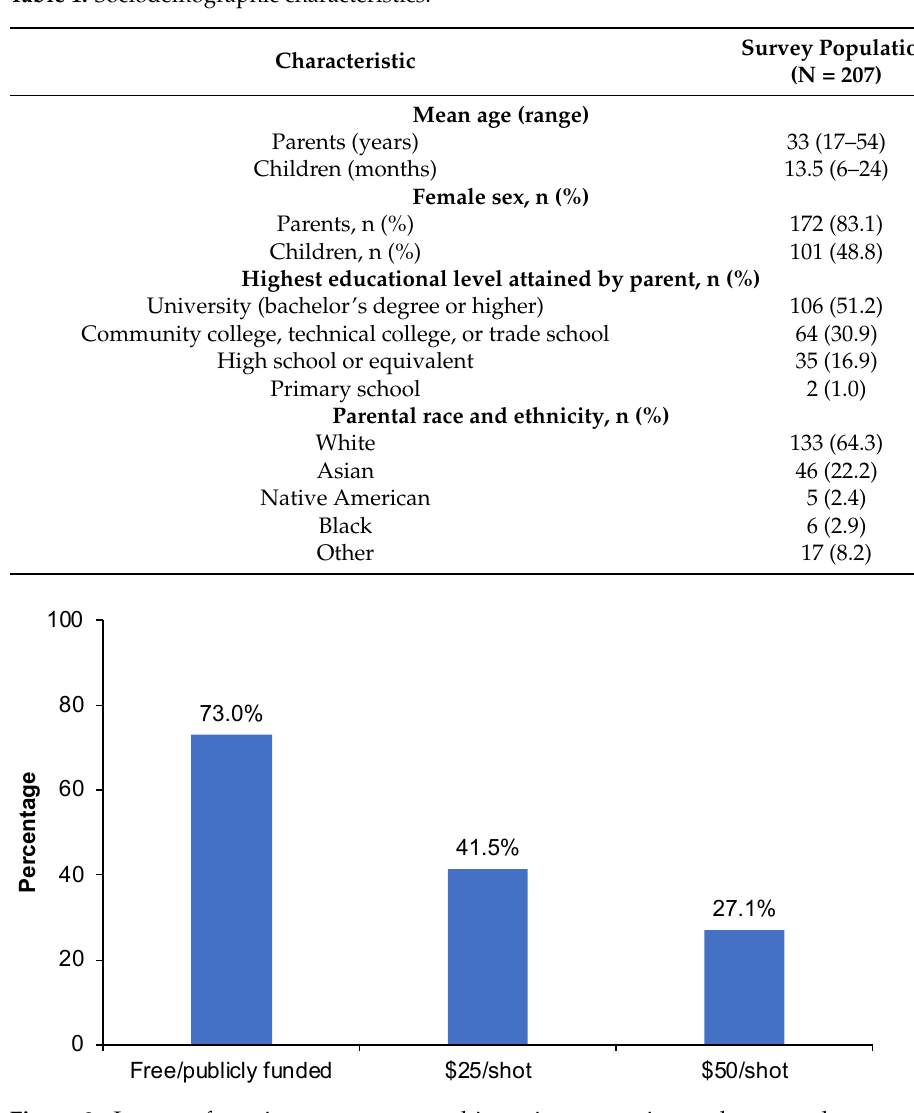
Table 1. Sociodemographic characteristics.